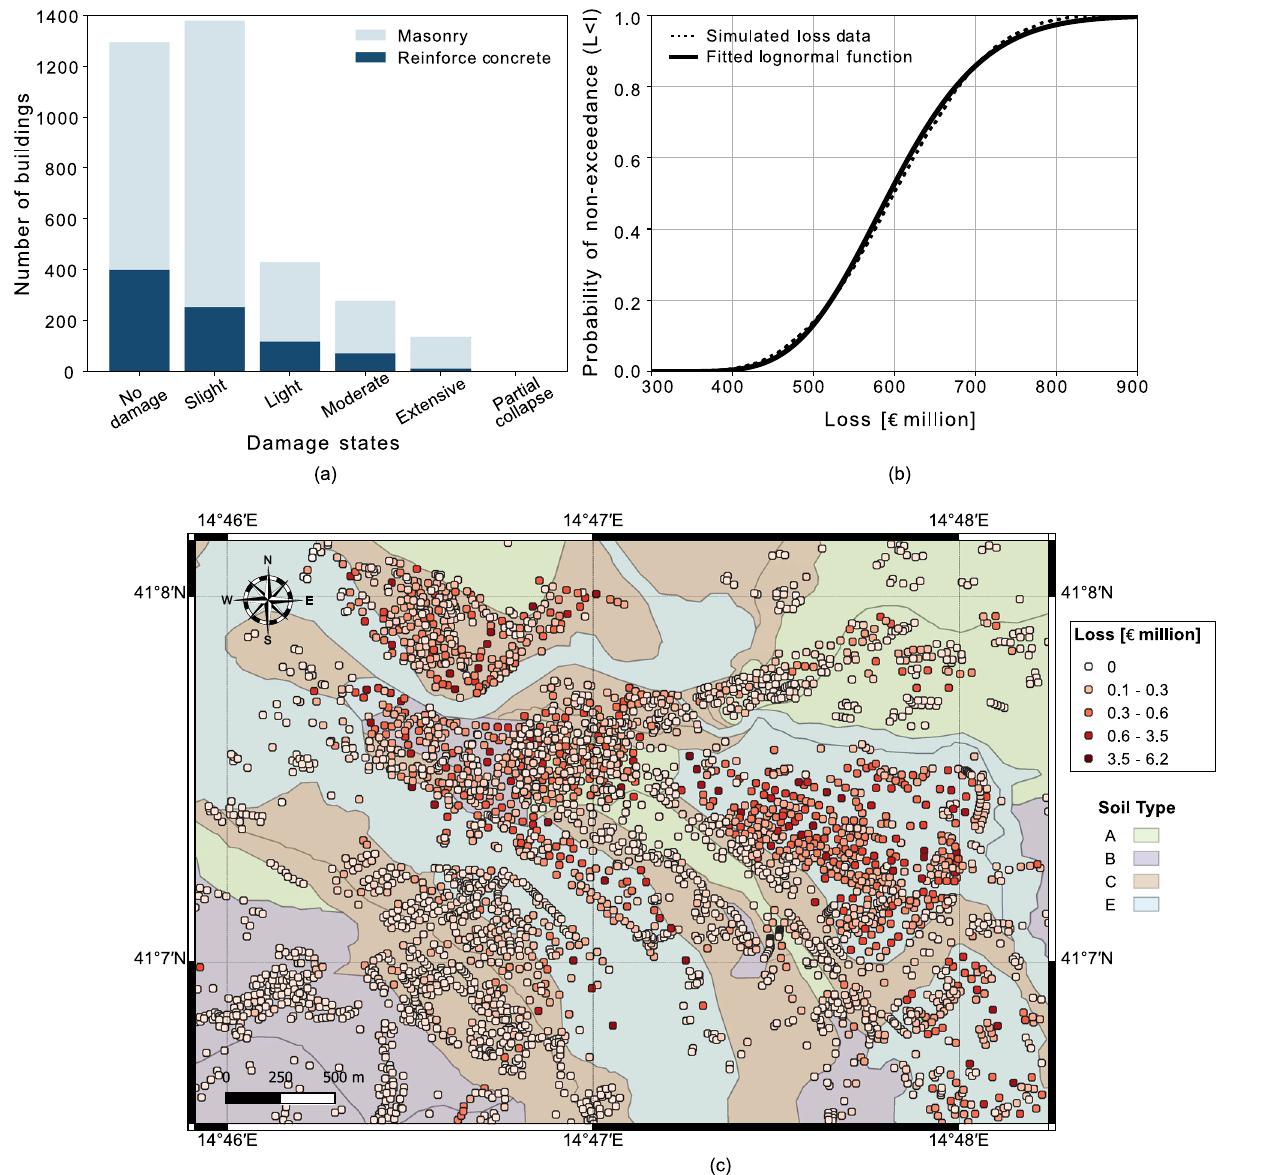
Figure 5. Loss results for vulnerability analysis: ( a ) proportions of masonry (light blue) and reinforce concrete (dark blue) building in each damage states; ( b ) simulated non-exceedance loss curve (dotted black line). The results shown are the mean of 10000 Monte Carlo simulations. Fitting of lognormal cumulative distribution function (solid black line) on the simulated loss data; ( c ) spatially distributed losses (mean of 10000 simulations) for the portfolio of buildings. Geological units: V s ,30 for each ground type ranges as follows: A (Rock, V s ,30 > 800 m/s-in green); B (very dense sand and gravel, V s ,30 : 360–800 m/s-in purple); C (dense sand and gravel, V s ,30 : 180–360 m/s-in brown); E (surface alluvium layer with thickness between 5 and 20 m, V s ,30 : 180–360 m/s or < 180 m/s-in light blue). This figure is created with QGIS version 3.18.2 (https:// www. qgis.